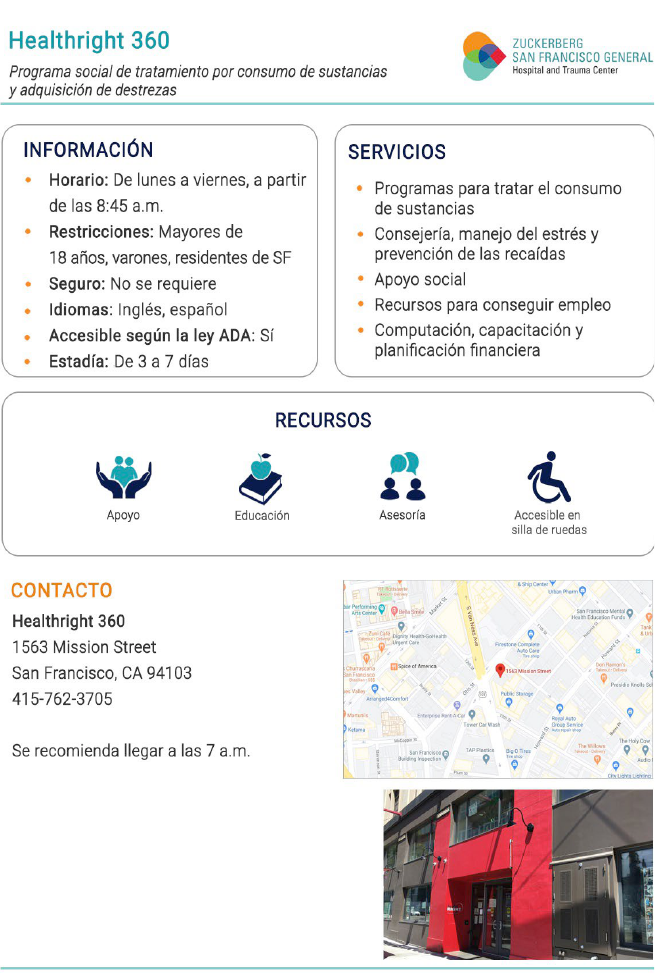
Figure 2. Example handout for a community substance use treat- ment center, in Spanish.